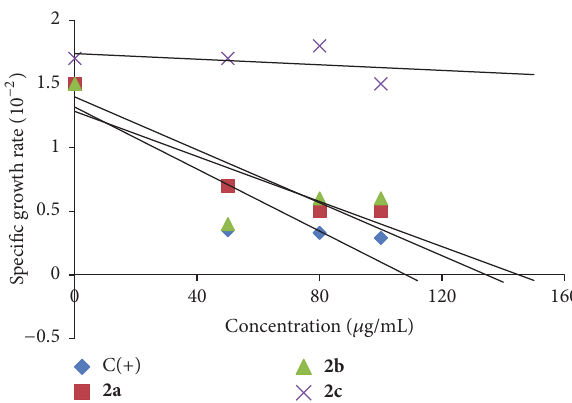
Figure 2: Minimum inhibitory concentration of 2a–2c against E. coli .